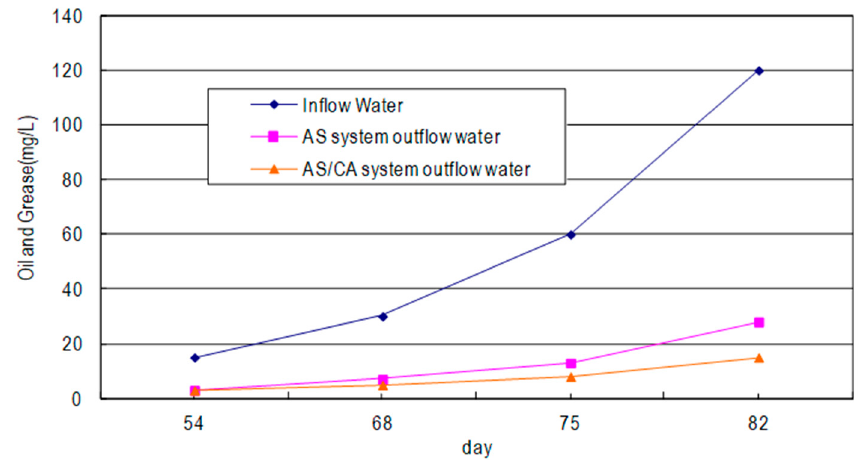
Figure 7. Treating oil and grease using AS system and AS/CA system.